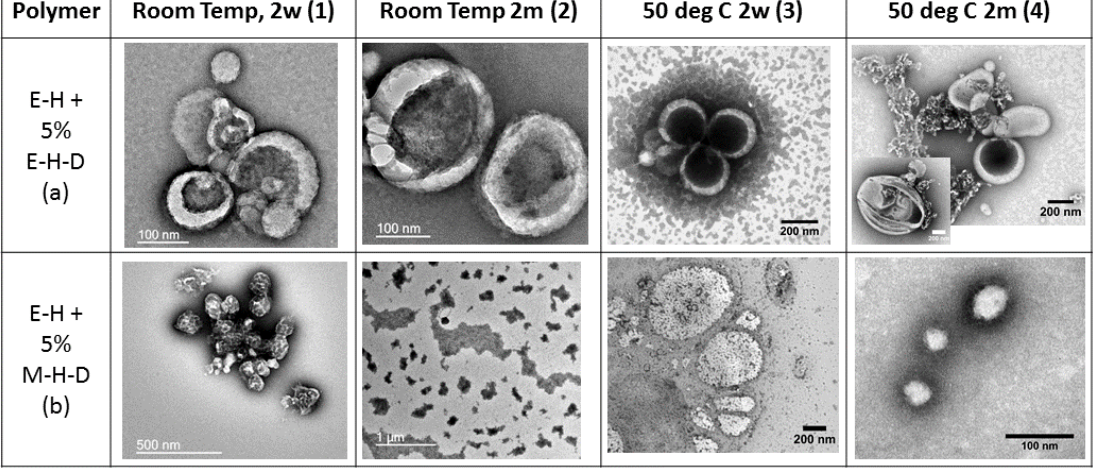
Figure 3 . TEM images of the mixture of block-copolymers. PEG-PHPMA + PEG-PHPMA-PDPA ( a ) and PEG-PHPMA + PMPC-PHPMA-PDPA ( b ) at room temperature for 2 weeks ( 1 ) and for 2 months ( 2 ), and at 50 °C for the same time periods ( 3 and 4 , respectively).